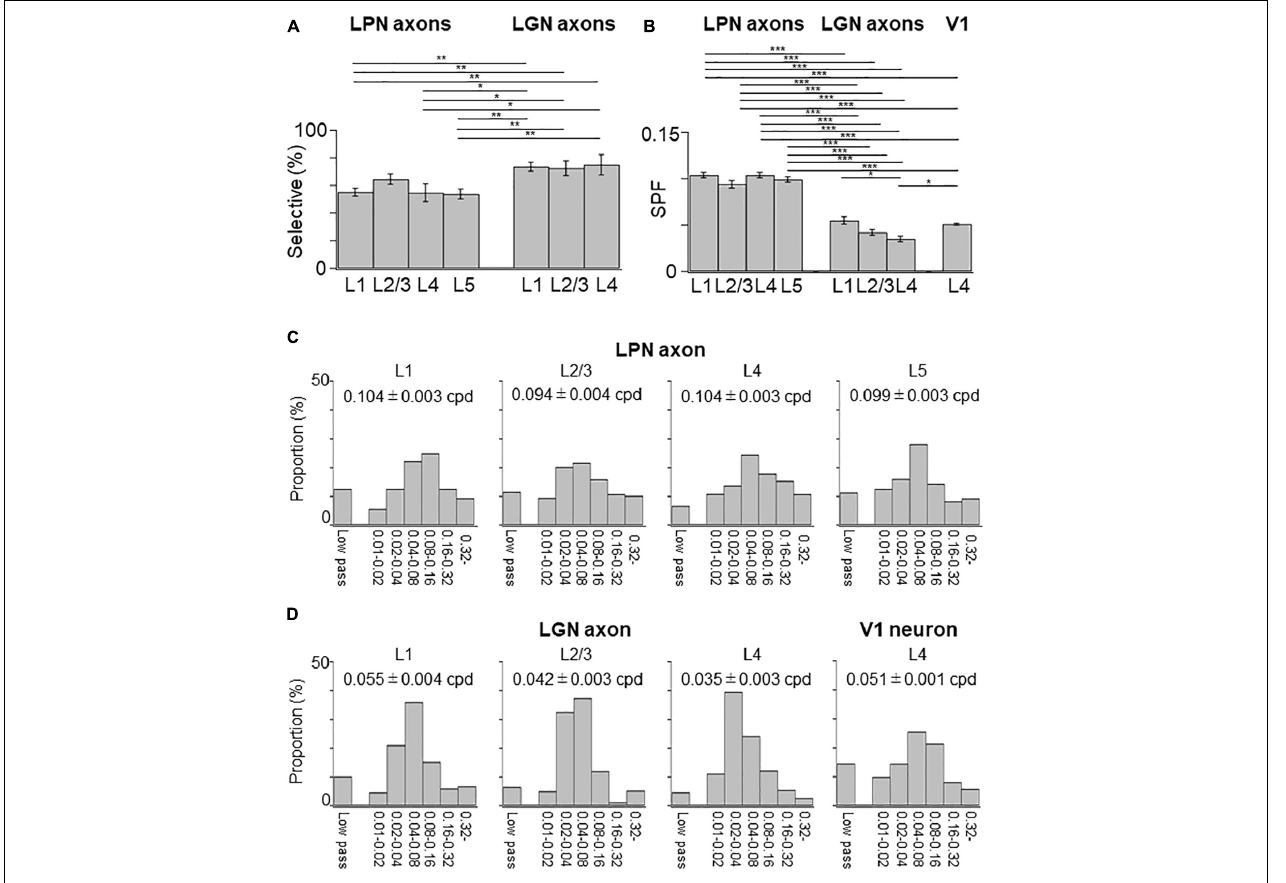
FIGURE 9 | Spatial frequency tuning of LPN and LGN boutons in V1. (A) The proportion of SPF-selective LPN and LGN boutons. The proportion of LPN boutons in the layers 1 and 5 was significantly different from that of LGN boutons in all layers ( P ≤ 0.01, Mann–Whitney U -test with Bonferroni correction). The proportion of LPN boutons in layer 4 was significantly different from that of LGN boutons in all layers (layer 1, p = 0.024; layer 2/3, p = 0.032; layer 5, p = 0.047, Mann–Whitney U -test with Bonferroni correction). (B) The mean preferred SPF of responsive LPN and LGN boutons. Mean preferred frequency of LPN boutons of all the layers had significant difference from LGN boutons of all the layers ( P ≤ 0.001, Mann–Whitney U -test with Bonferroni correction). Mean preferred frequency among LPN boutons had no significant difference (between layers 1 and 2/3, p = 0.896; other pairs, p = 1, Mann–Whitney U -test with Bonferroni correction). Mean preferred frequency of the layer 4 LGN boutons was significantly different from LGN boutons of layer 1 and V1 neurons in layer 4 (LGN boutons in layer 1, p = 0.037; V1 neurons in layer 4, p = 0.013, Mann–Whitney U -test with Bonferroni correction). (C) The distribution of the preferred SPFs of LPN boutons in the layer 1 (left, n = 893 boutons from six mice, 13 FOVs), layer 2/3 (second from left, n = 659 boutons from six mice, 9 FOVs), layer 4 (second from right, n = 844 boutons from five mice, 8 FOVs), and layer 5 (right, n = 1,000 boutons from three mice, 13 FOVs). (D) The distribution of the preferred SPFs of LGN boutons in the layer 1 (left, n = 3,817 boutons from 20 mice, 42 FOVs), layer 2/3 (second from left, n = 2,669 boutons from 18 mice, 29 FOVs), and layer 4 (second from right, n = 5,576 boutons from 20 mice, 55 FOVs), and V1 neurons in the layer 4 (right, n = 6,210 neurons from 9 mice, 12 volumes). LPN, lateral posterior nucleus; LGN, lateral geniculate nucleus; V1, primary visual cortex; SPF, spatial frequency; FOV, field-of-view; cpd, cycle per degree. * P ≤ 0.05; ** P ≤ 0.01; *** P ≤ 0.001. The data of LGN axons and V1 neurons are re-use from the previous publication (Kondo and Ohki,